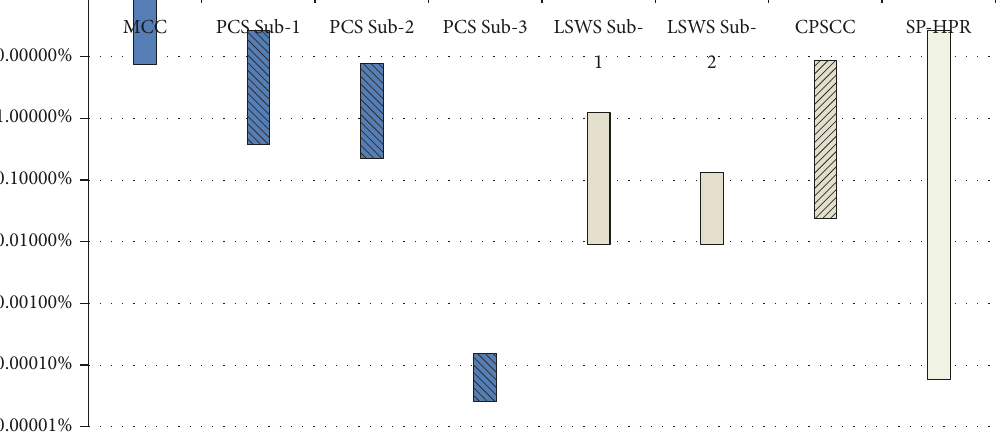
Figure 5: Comparison of relative deposit activity of SP-HPR, MCC [14], PCS [15], LSWS [16], and CPSCC [17] subsystems components compared to the MCC MCP activity (PCS-i:LSWS-i:CPSCC-i:SP-HPR-i / MCC